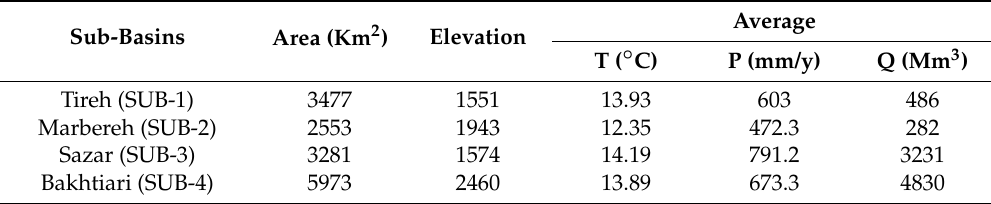
Figure 1. The map of the Dez River Basin; ( a ) the sub-basins, main streams, and location of the hydrometric stations and reservoirs ( b ) its location in Iran. hydrometric stations and reservoirs ( b ) its location in Iran. Table 1. The description of the sub-basins of the Dez River Table 1. The description of the sub-basins of the Dez River basin.